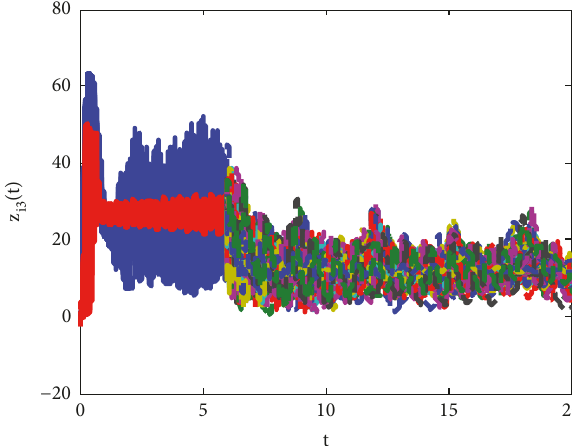
Figure 4: (Color online) Evolution patterns of community network 𝑧 (𝑡) with 𝑡 . 𝑖3